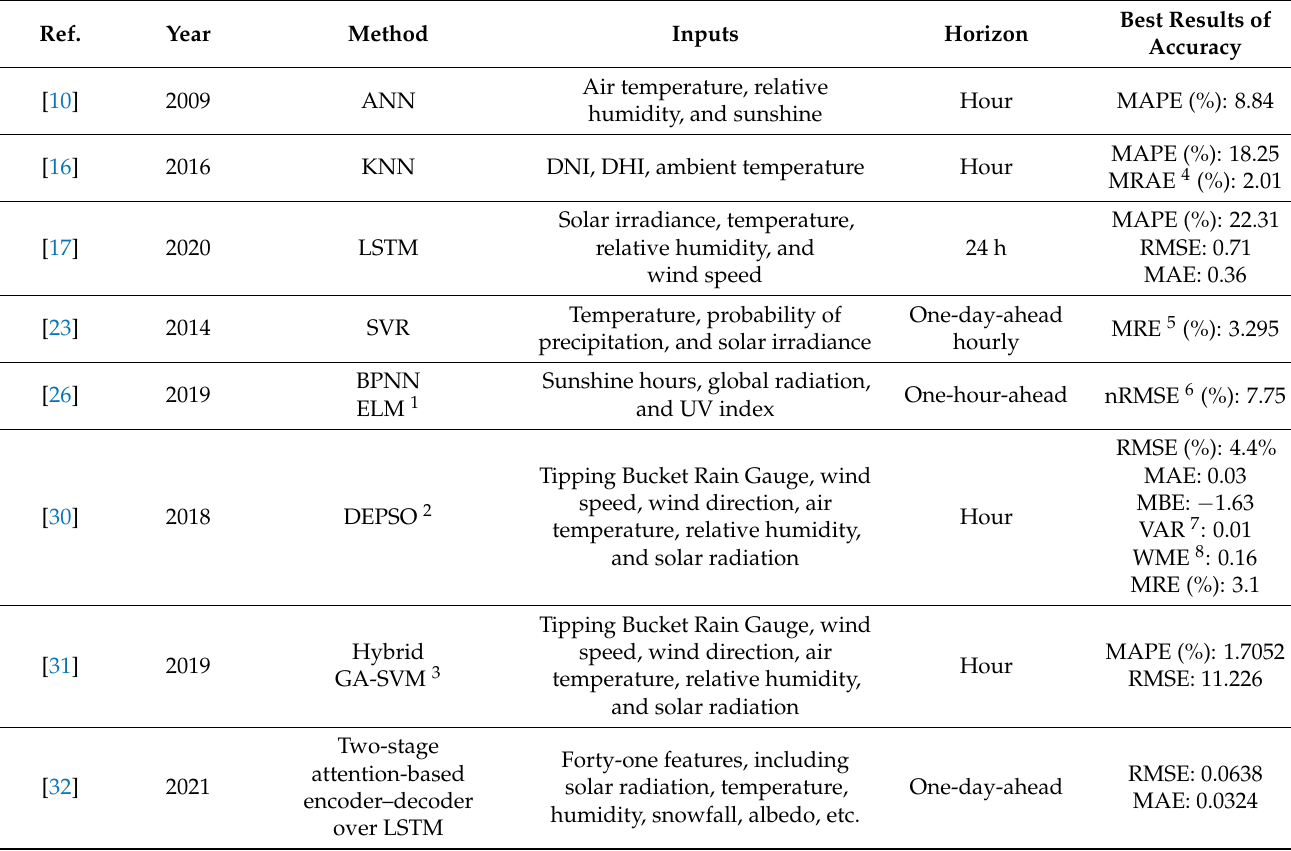
Table 1. Summary of different forecasting algorithms, data inputs, and